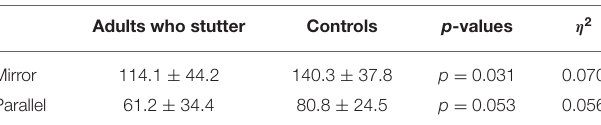
TABLE 3 | Tapping